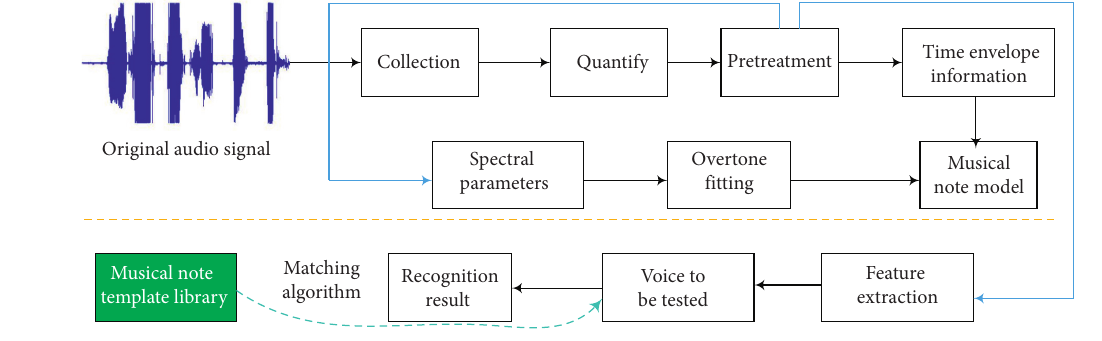
Figure 2: Flowchart of musical note modeling.